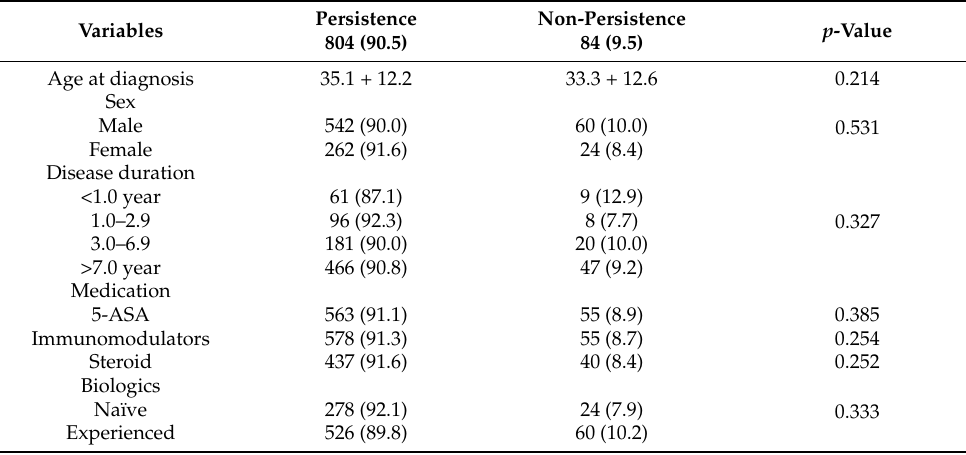
Table 4. Risk factors of non-persistence in ustekinumab